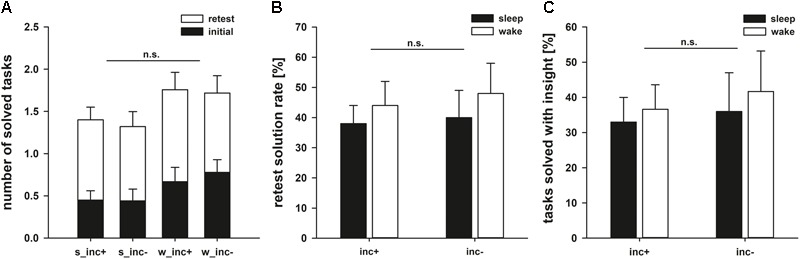
(A) Performance after the first (black bars) and the second (white bars) encounters. Note that the maximum number of tricks to be solved was 3. (B) Retest solution rates. As the insight tasks were not presented again when they had been solved in the initial phase, 100% represents having solved all remaining insight tasks. (C) Percentage of tasks that were solved with insight.